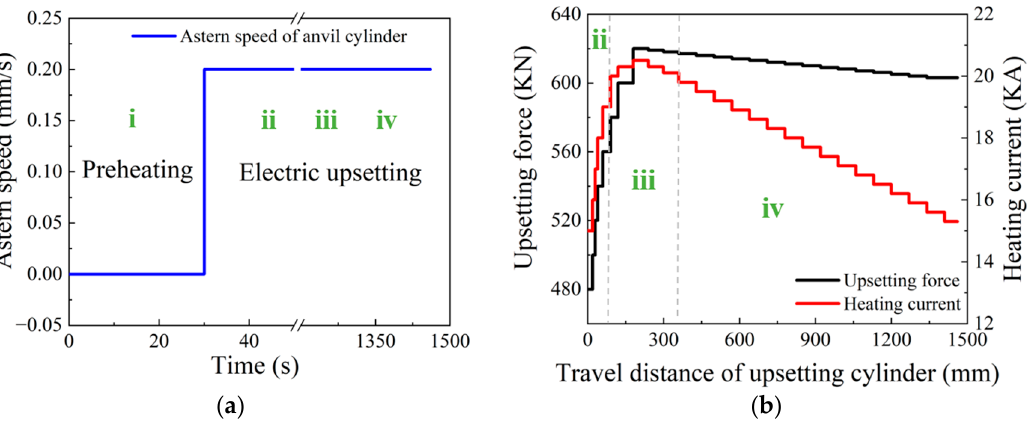
Figure 6. Loading path of electric upsetting processing parameters: ( a ) astern speed of anvil cylinder, and ( b ) upsetting force and heating current. (i, ii, iii and iv represent the four stages of electric upsetting process)